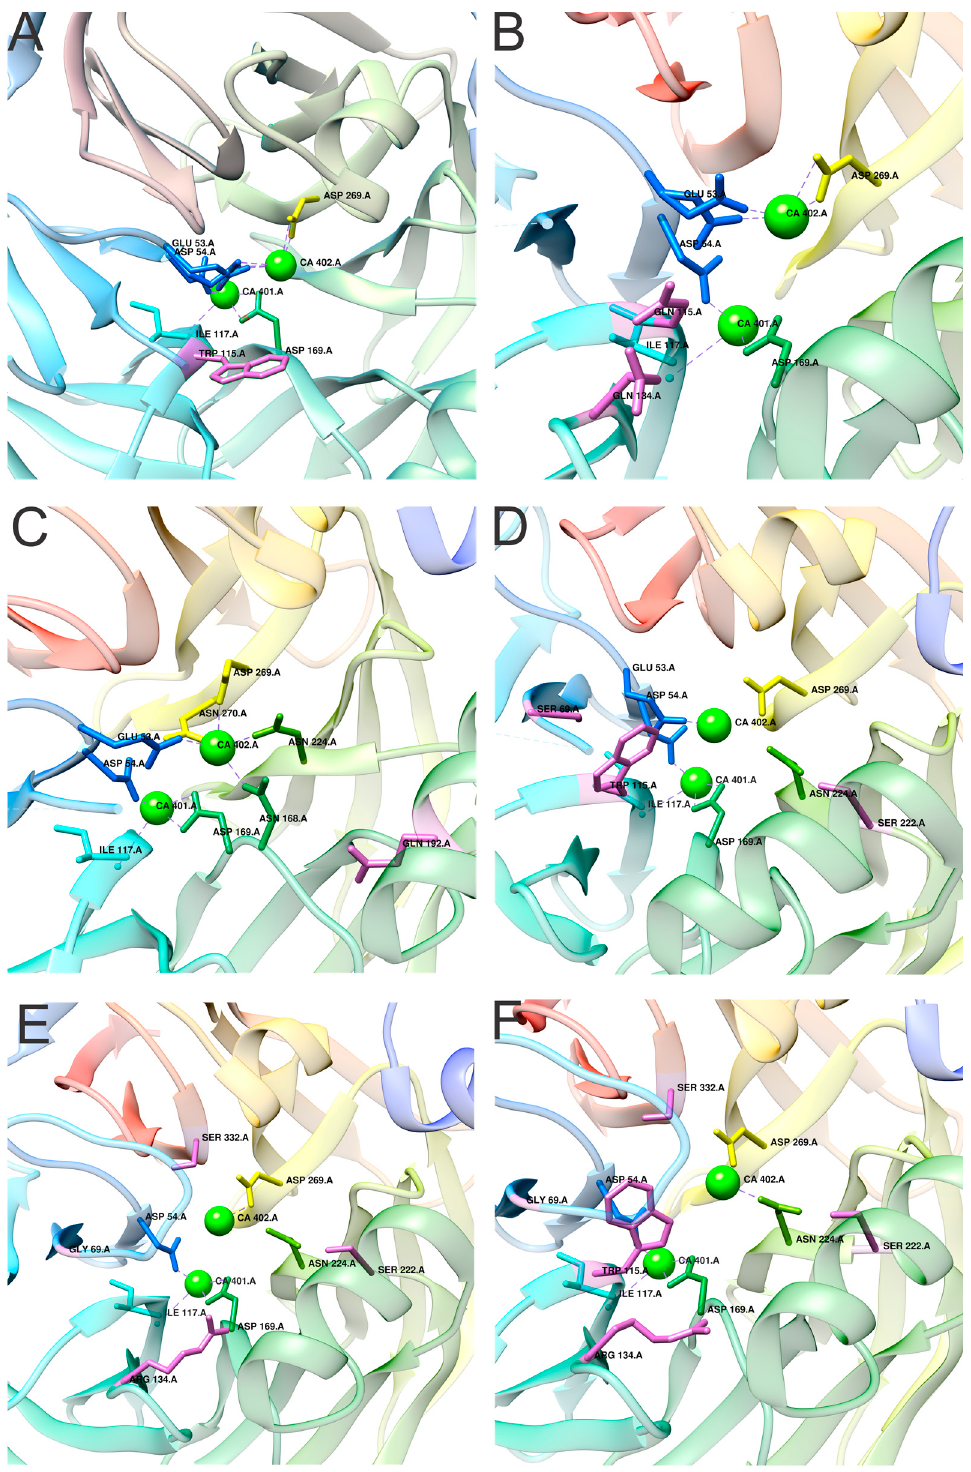
Figure 5. Paraoxonase 1 structural insight into active site of mutated proteins. Introduced mutations are related to protein specificity, activity or evolution. ( A – C ) Protein mutants related to enzymatic activity. ( A ) A mutant exhibiting only OP activity (H115W; PDB id. 4HHO [46]). ( B ) A mutant exhibiting convergence between OP and lactonase activity (H115Q and H134Q; PDB id. 4HHQ [46]). ( C ) A mutant affecting HDL binding and active site geometry (K192Q; PDB id. 4Q1U [47]). ( D – F ) Mutations related to the discovery of evolutionary trajectories. ( D ) L69S, H115W, and F222S (PDB id. 6G82 [49]); ( E ) L69S, H134R, F222S, and T332S (PDB id. 6GMU [49]); ( F ) L69S, H115W, H134R, F22S, and T332S (PDB id. 6H0A [49]). Mutated residues are in magenta.